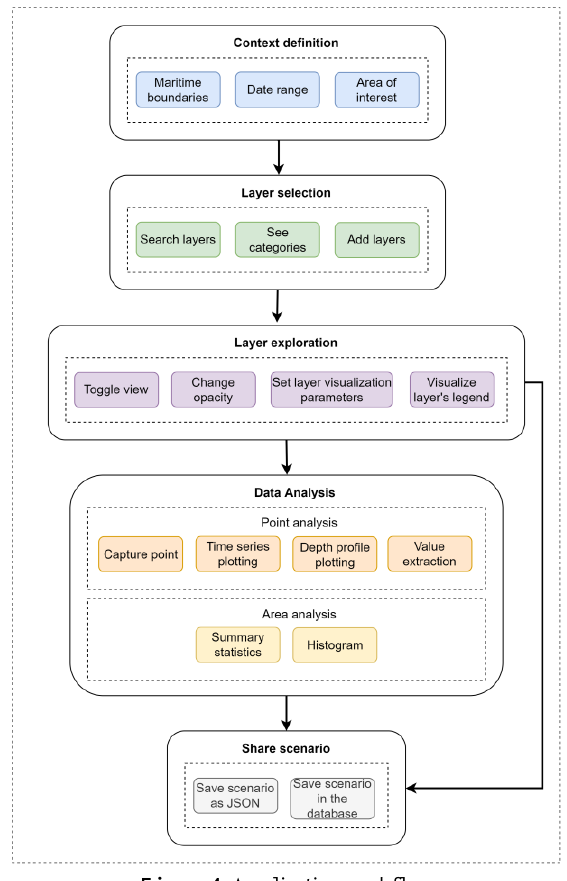
Figure 4 . Application workflow